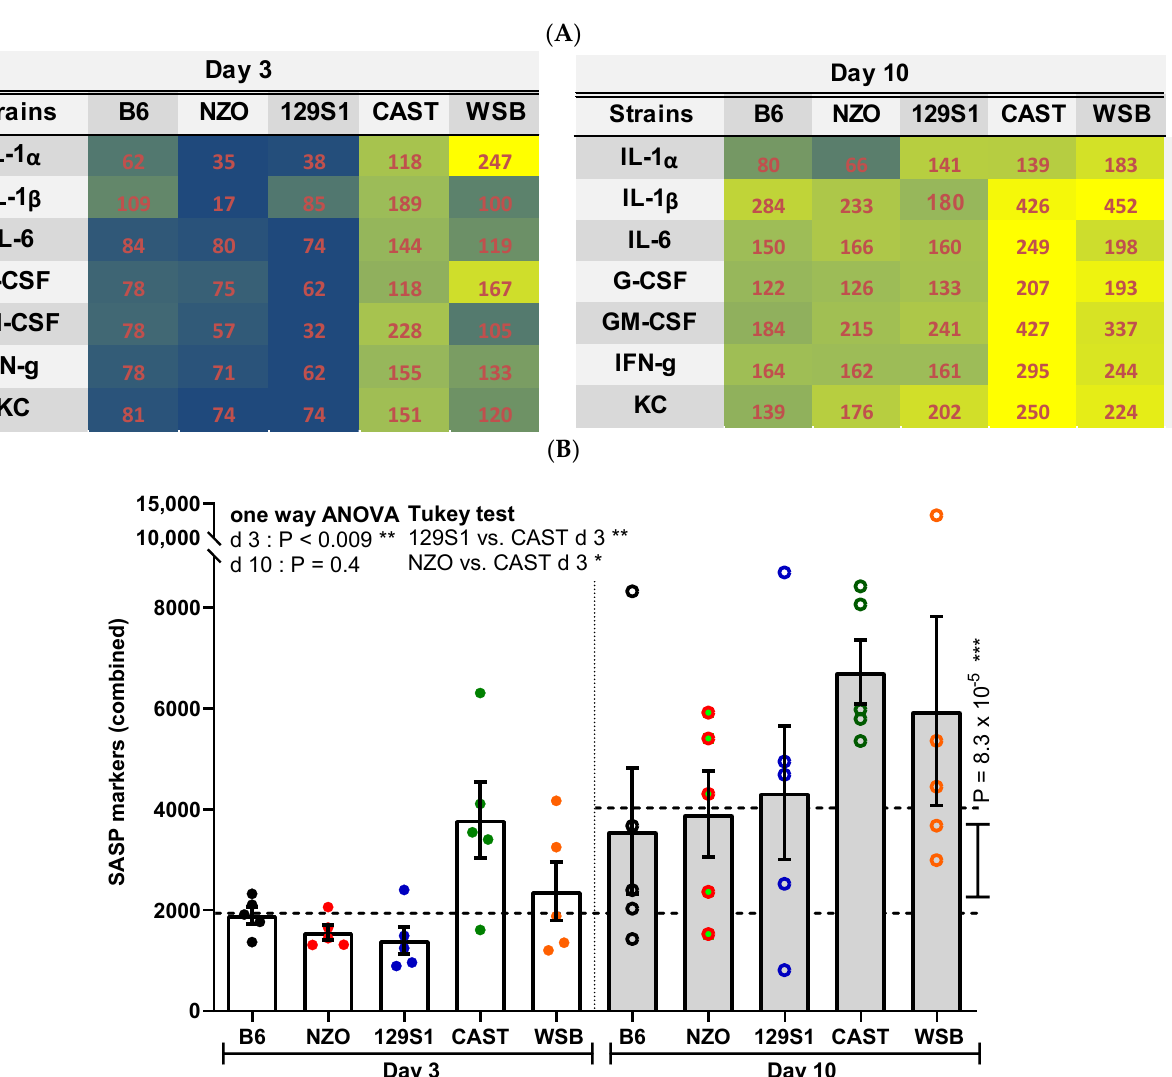
Figure 5. Analysis of cellular senescence using senescence associated secretory phenotype (SASP). ( A ) Protein levels of the indicated seven SASP factors are visualized by heatmap for days 3 and 10 after irradiation. Mean values of the seven SASP factors are depicted for each mouse strain (average normalized to day 3) to define the overall levels of SASP secretion (signal intensities ranked from lowest = blue to highest = bright yellow). ( B ). Corresponding results are presented as means ± SEM ( n = 5 mice for each strain). Significance between means of strains and means of time points were tested by the one-way ANOVA and t -test, respectively. Tukey’s test was performed as a post-hoc analysis in the case of multiple comparisons. Results from days 3 and 10 are tested separately. * p < 0.05; ** p < 0.01; *** p < 0.001.